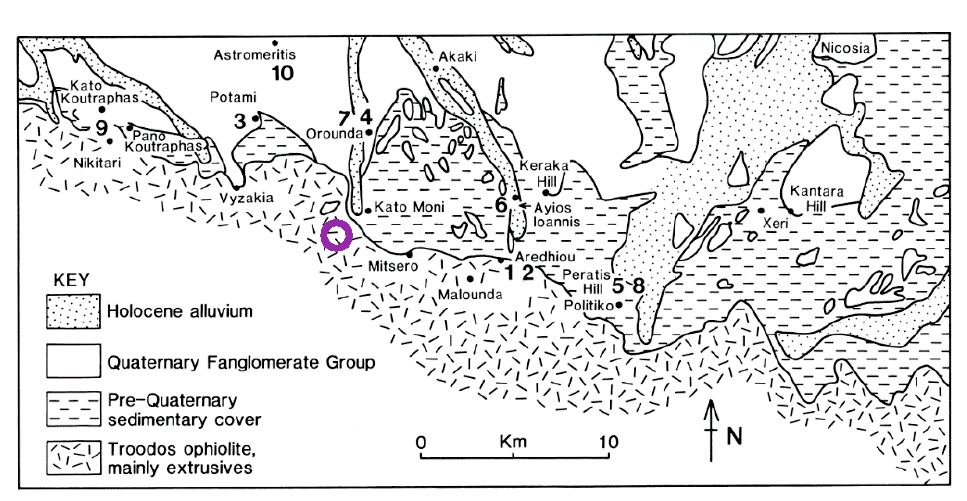
Figure 4. Simplified geological map of the study area (purple circle). From [25].